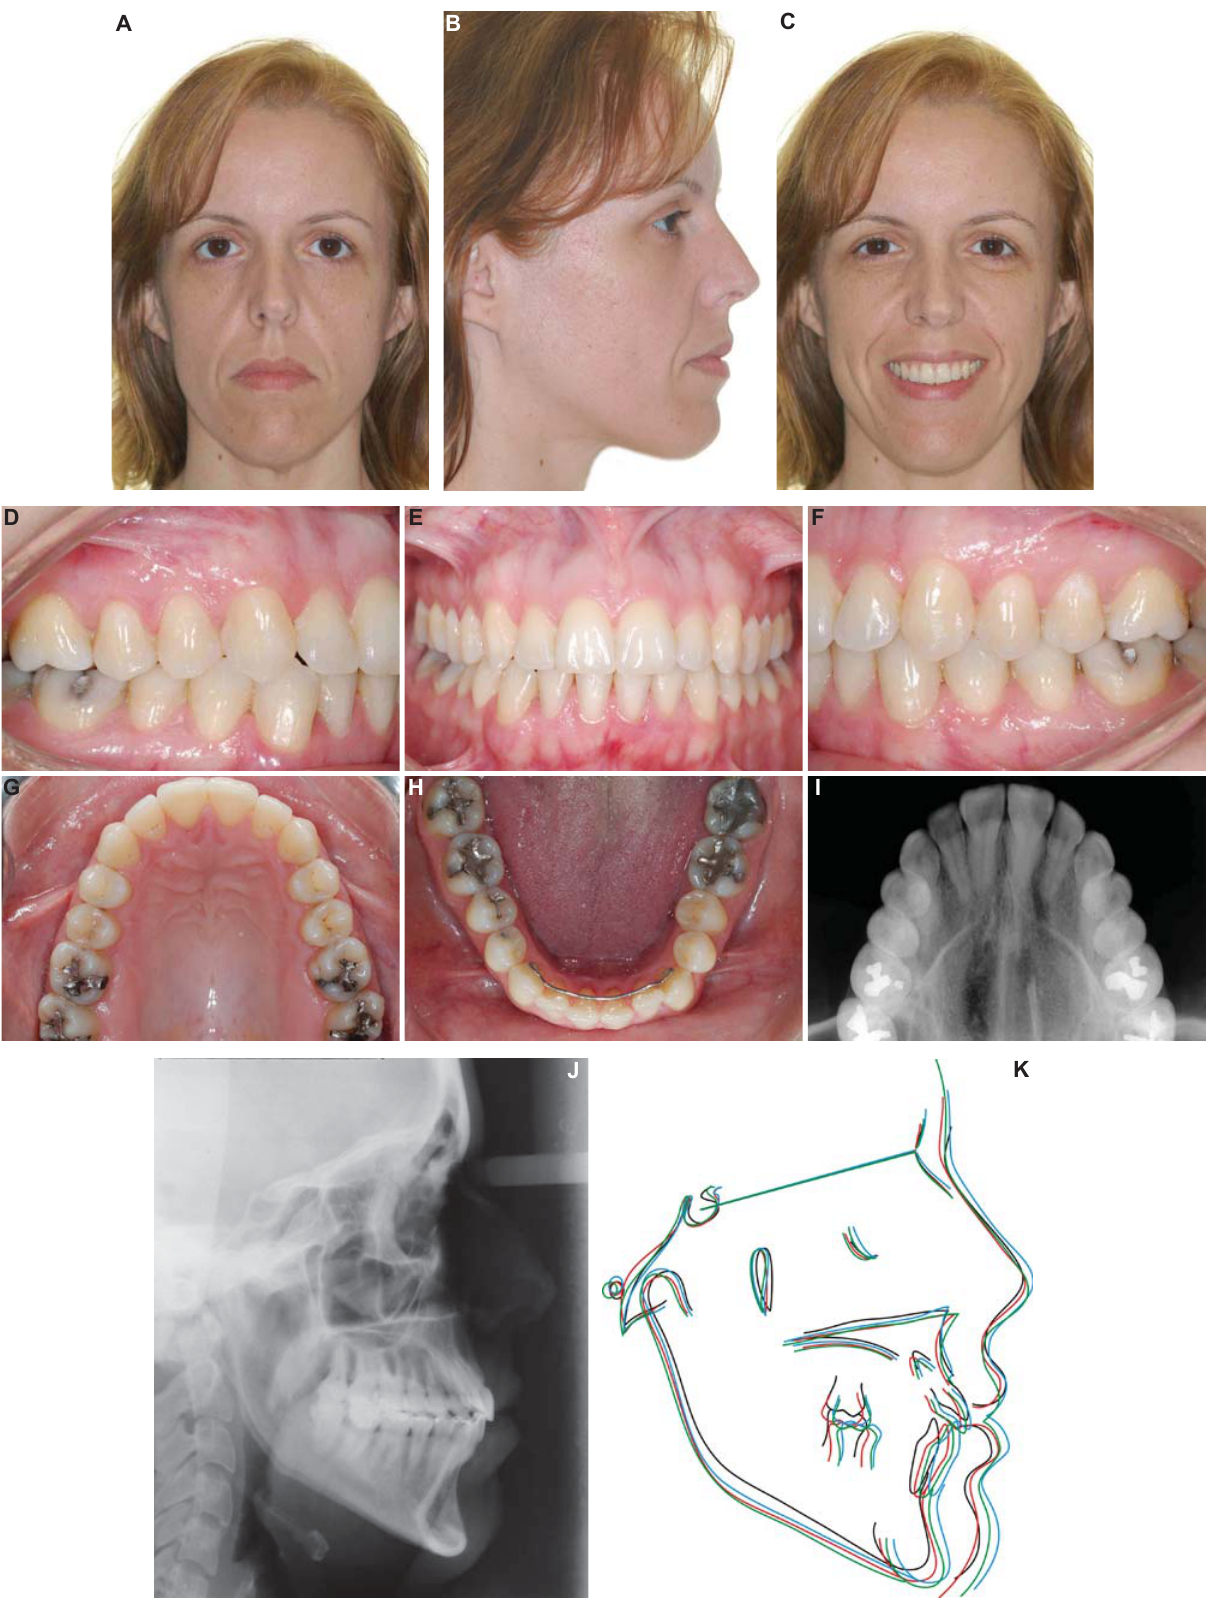
Figure 10- 22-year posttreatment extraoral (A and C) and intraoral (D-H) photographs. Lateral cephalograms (J), occlusal (cid:12)(cid:7)(cid:19)(cid:5)(cid:13)(cid:20)(cid:12)(cid:7)(cid:21)(cid:22)(cid:2)(cid:14)(cid:3)(cid:18)(cid:9)(cid:2)(cid:6)(cid:13)(cid:6)(cid:7)(cid:8)(cid:2)(cid:25)(cid:29)(cid:21)(cid:26)(cid:12)(cid:21)(cid:13)(cid:25)(cid:5)(cid:6)(cid:5)(cid:13)(cid:4)(cid:25)(cid:30)(cid:2)(cid:5)(cid:4)(cid:5)(cid:6)(cid:5)(cid:7)(cid:8)(cid:2)(cid:14)(cid:31)(cid:8)(cid:7)(cid:23)!(cid:18)(cid:9)(cid:2)(cid:10)(cid:4)(cid:7)(cid:8)(cid:2)(cid:14)(cid:12)(cid:26)(cid:19)(cid:18)(cid:9)(cid:2)(cid:10)(cid:12)(cid:25)(cid:6)(cid:2)(cid:27)(cid:13)(cid:8)(cid:8)(cid:13)"(cid:16)(cid:29)(cid:21)(cid:2)(cid:14)(cid:20)(cid:12)(cid:26)(cid:26)(cid:4)(cid:18)(cid:9)(cid:2)(cid:7)(cid:4)(cid:19)(cid:2)(cid:25)(cid:26)(cid:23)(cid:13)(cid:4)(cid:19)(cid:2)(cid:27)(cid:13)(cid:8)(cid:8)(cid:13)"(cid:16)(cid:29)(cid:21)(cid:2)(cid:14)(cid:31)(cid:8)(cid:29)(cid:26)(cid:18)(cid:2)(cid:14)#(cid:18)(cid:2)(cid:14)(cid:21)(cid:7)(cid:6)(cid:5)(cid:26)(cid:4)(cid:6)(cid:2) authorized the publication of these